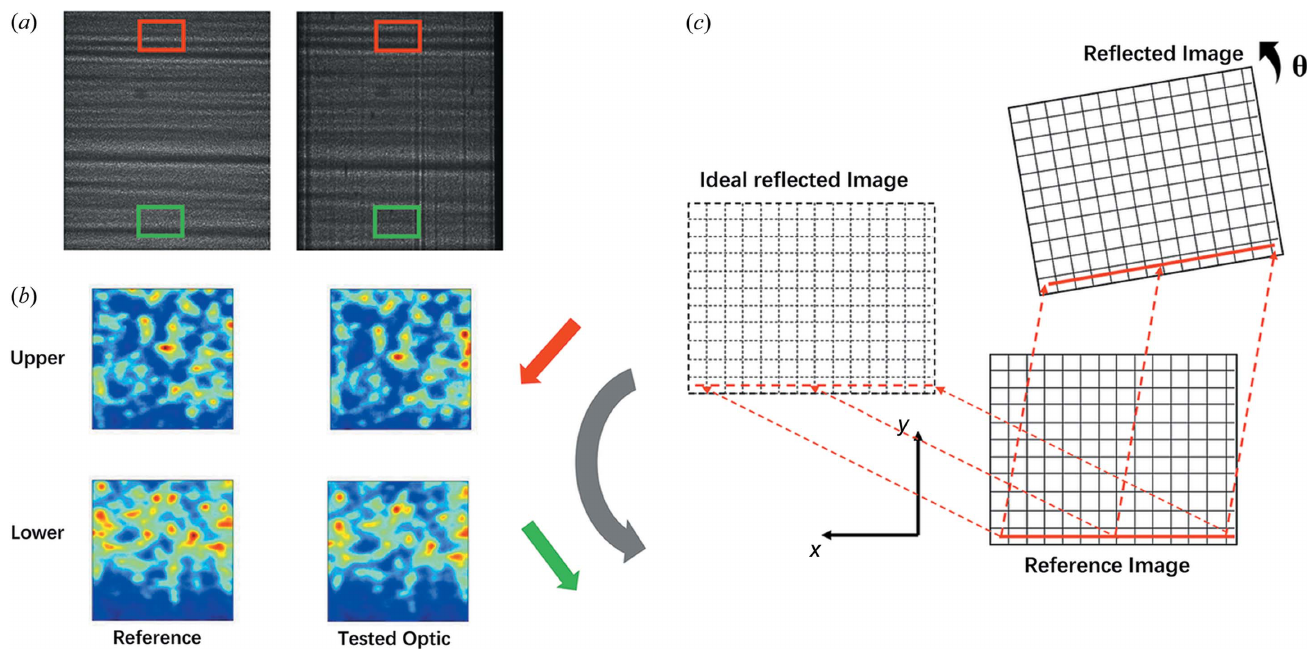
Figure 3 ( a ) Raw speckle images of the reference beam (left) and the reflected beam (right) from the optic being tested. The magnified speckle patterns from the sub-regions (red and green rectangular boxes), extracted from ( a ) are shown in ( b ). The red arrow shows the shift of the speckle pattern from the upper part of the image of the reference beam to the upper part of image of the reflected beam. Likewise, the green arrow shows the shift of the speckle pattern extracted from the lower parts of the reference and reflected images. Comparing the speckle pattern shifts from the upper part and the lower part of the two raw images together, we observe that the image of the reflected beam is rotated with respect to the image of the reference beam. Panel ( c ) demonstrates how the rotation angle affects the calculated y displacement. The y direction is along the mirror width. Since the optical surface of the X-ray mirror should be very smooth, the calculated y displacement iy should be small along the mirror length while the speckle generator is translated along the x direction. If the mirror is well aligned, the calculated iy should be close to zero. When the mirror is rotated about the z axis (not shown in the image), the reflected image will be rotated by the same angle. As shown in ( c ), the calculated iy will have a linear relationship with the x